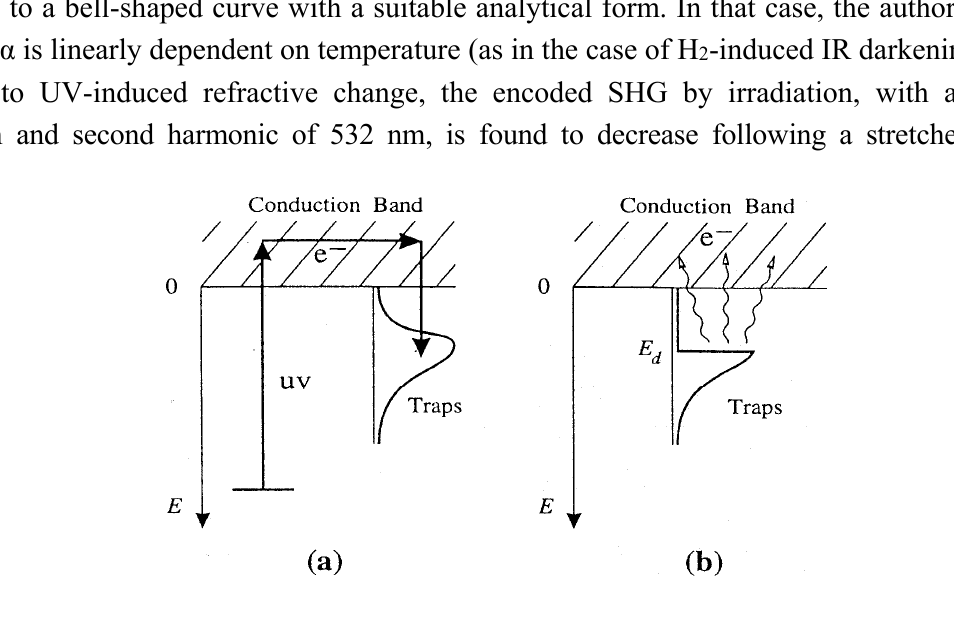
Figure 8. Erdogan model, reprinted with permission from [1,17]. Copyright 1994 OSA. ( a ) Uniform population regardless of the trapping energy depth; ( b ) Progressive trap depopulation according to the trapping energy.